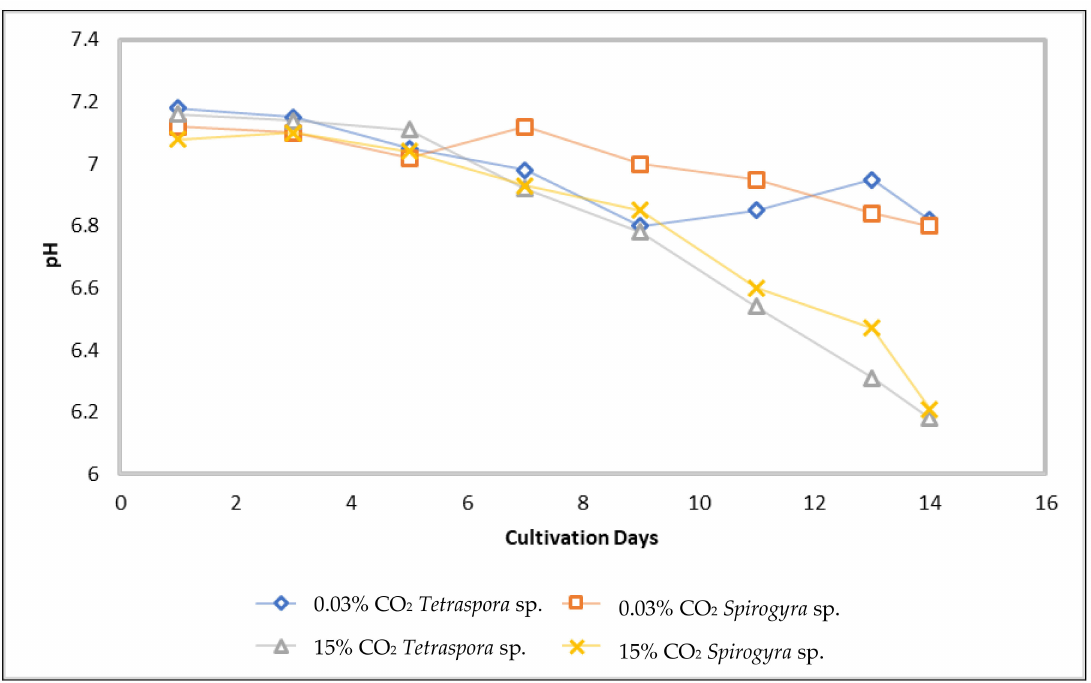
Figure 1. pH profiles during the 14 day cultivation of Tetraspora sp. and Spirogyra